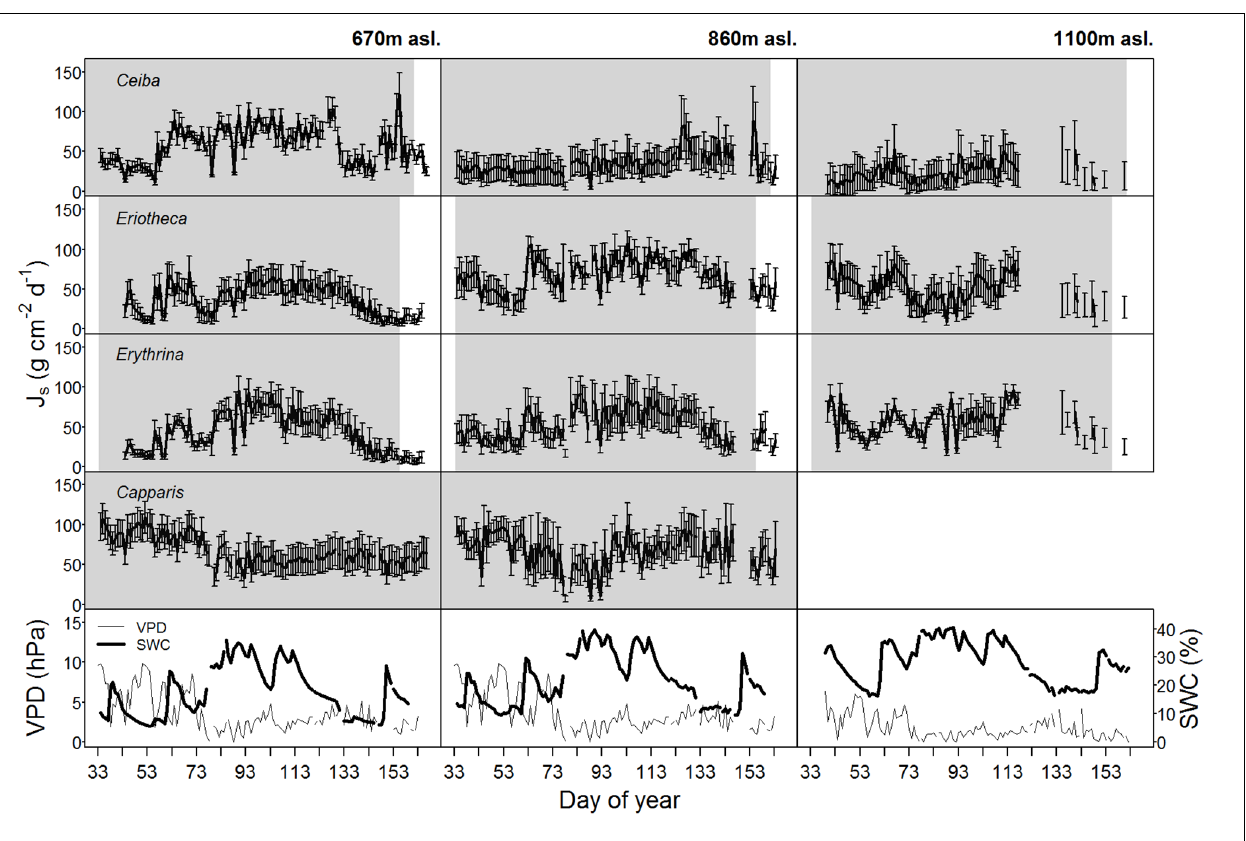
FIGURE 1 | Daily sap flux densities (Js) ( n = 4 trees per elevation) of the four study species as well as vapor pressure deficit (VPD, values at 670 m were adopted from 860 m asl) and soil water content (SWC) over the whole study period in the year 2015. Gray shaded area indicates foliated period, error bars indicate standard